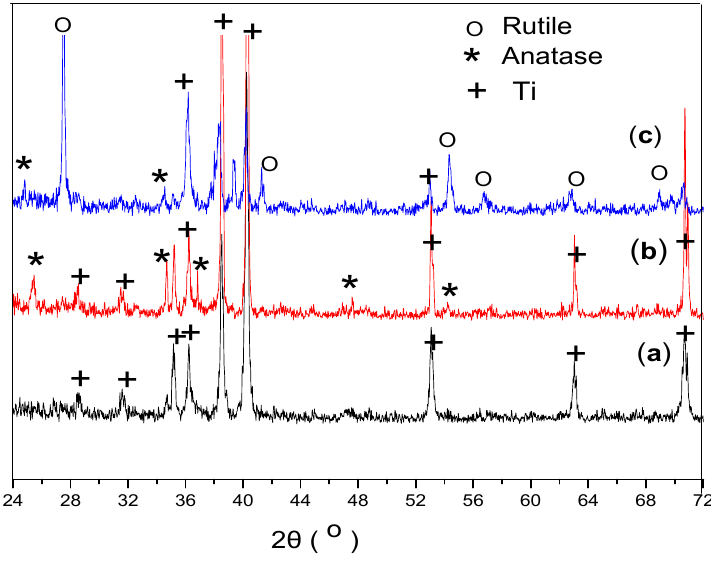
Figure 1. X-ray diffraction (XRD) spectra of the TiO after heat treatment at various temperatures for 1 h in air: (b) 450 °C; (c) 700 °C.